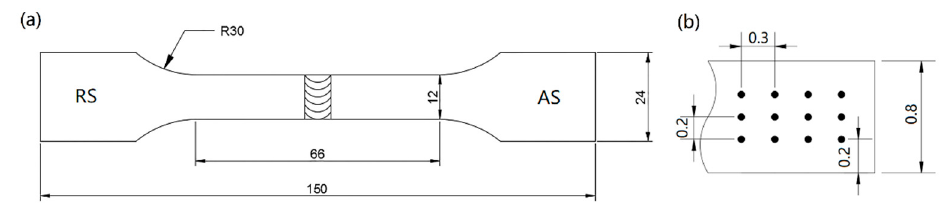
Figure 3. Tensile test and hardness test: ( a ) specific dimensions of the tensile specimen; ( b ) schematic diagram of the hardness measurement location (unit: